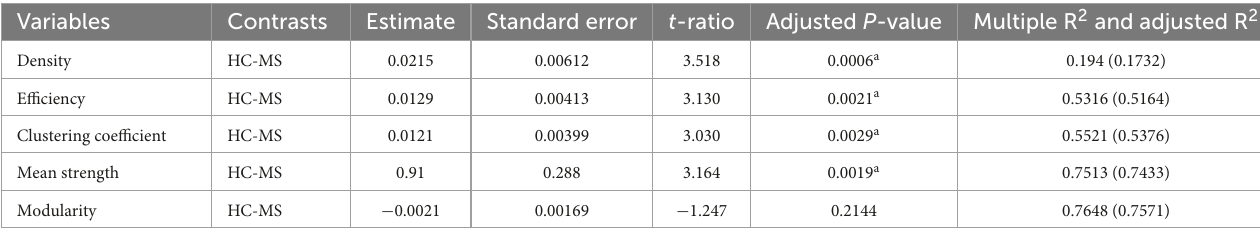
TABLE 2 Specific comparisons between healthy controls (HC) and patients with multiple sclerosis (pwMS) and each global network. Variables Contrasts